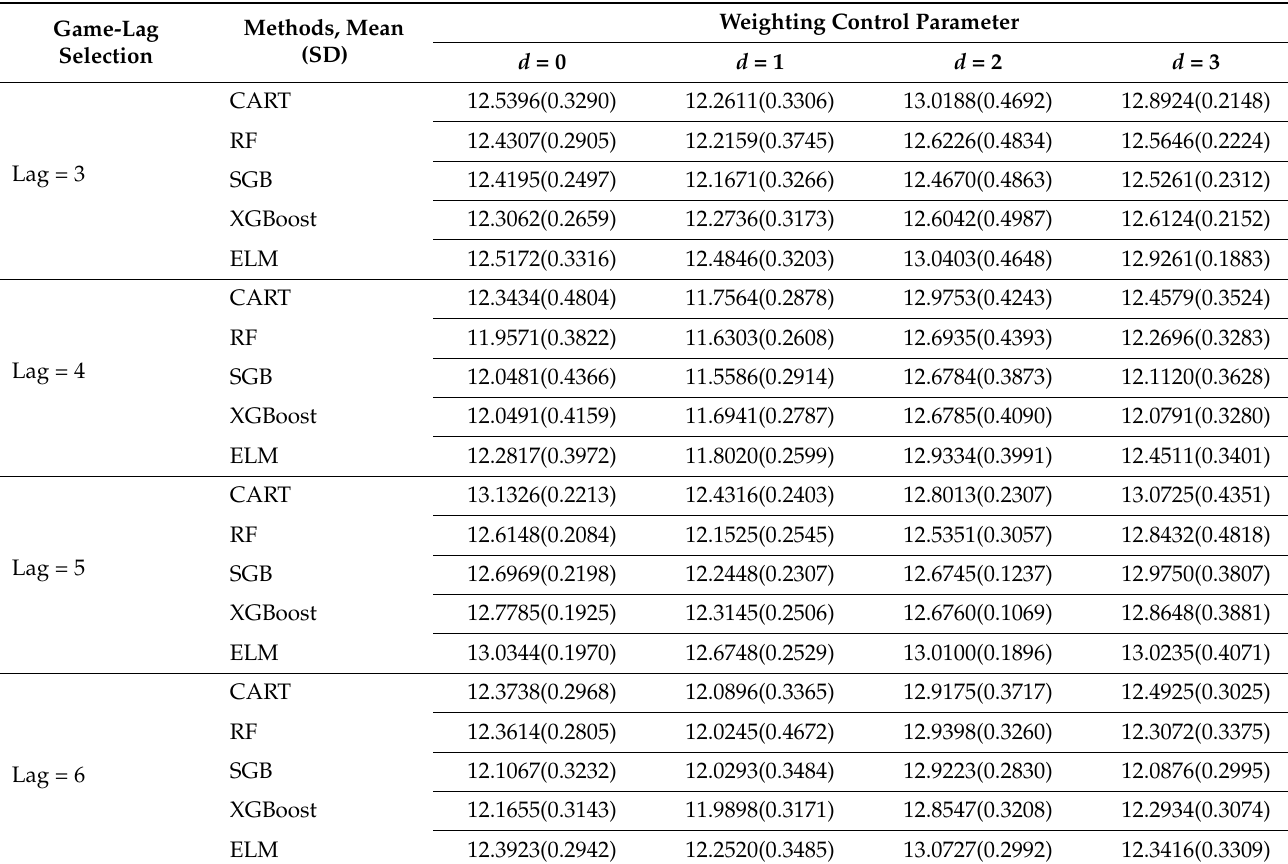
Table 2. Performance metrics of the proposed prediction